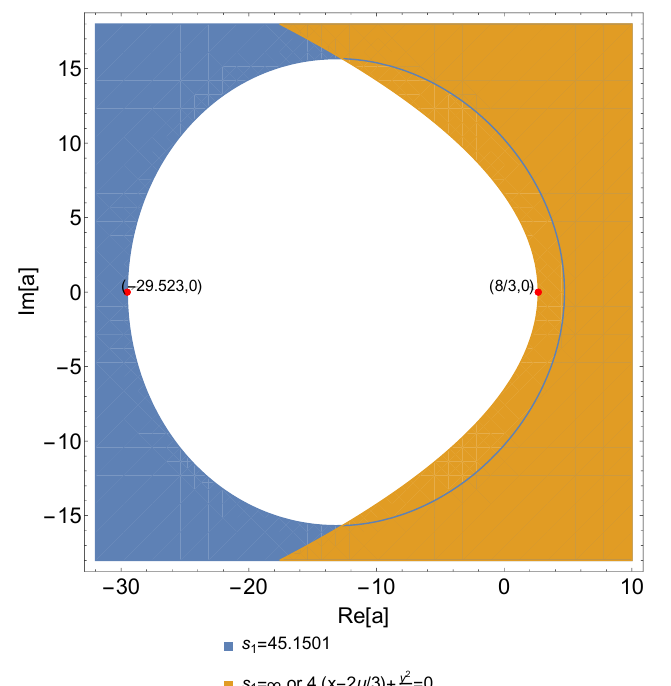
Figure 1. The analyticity domain in the complex a -plane for 2 µ